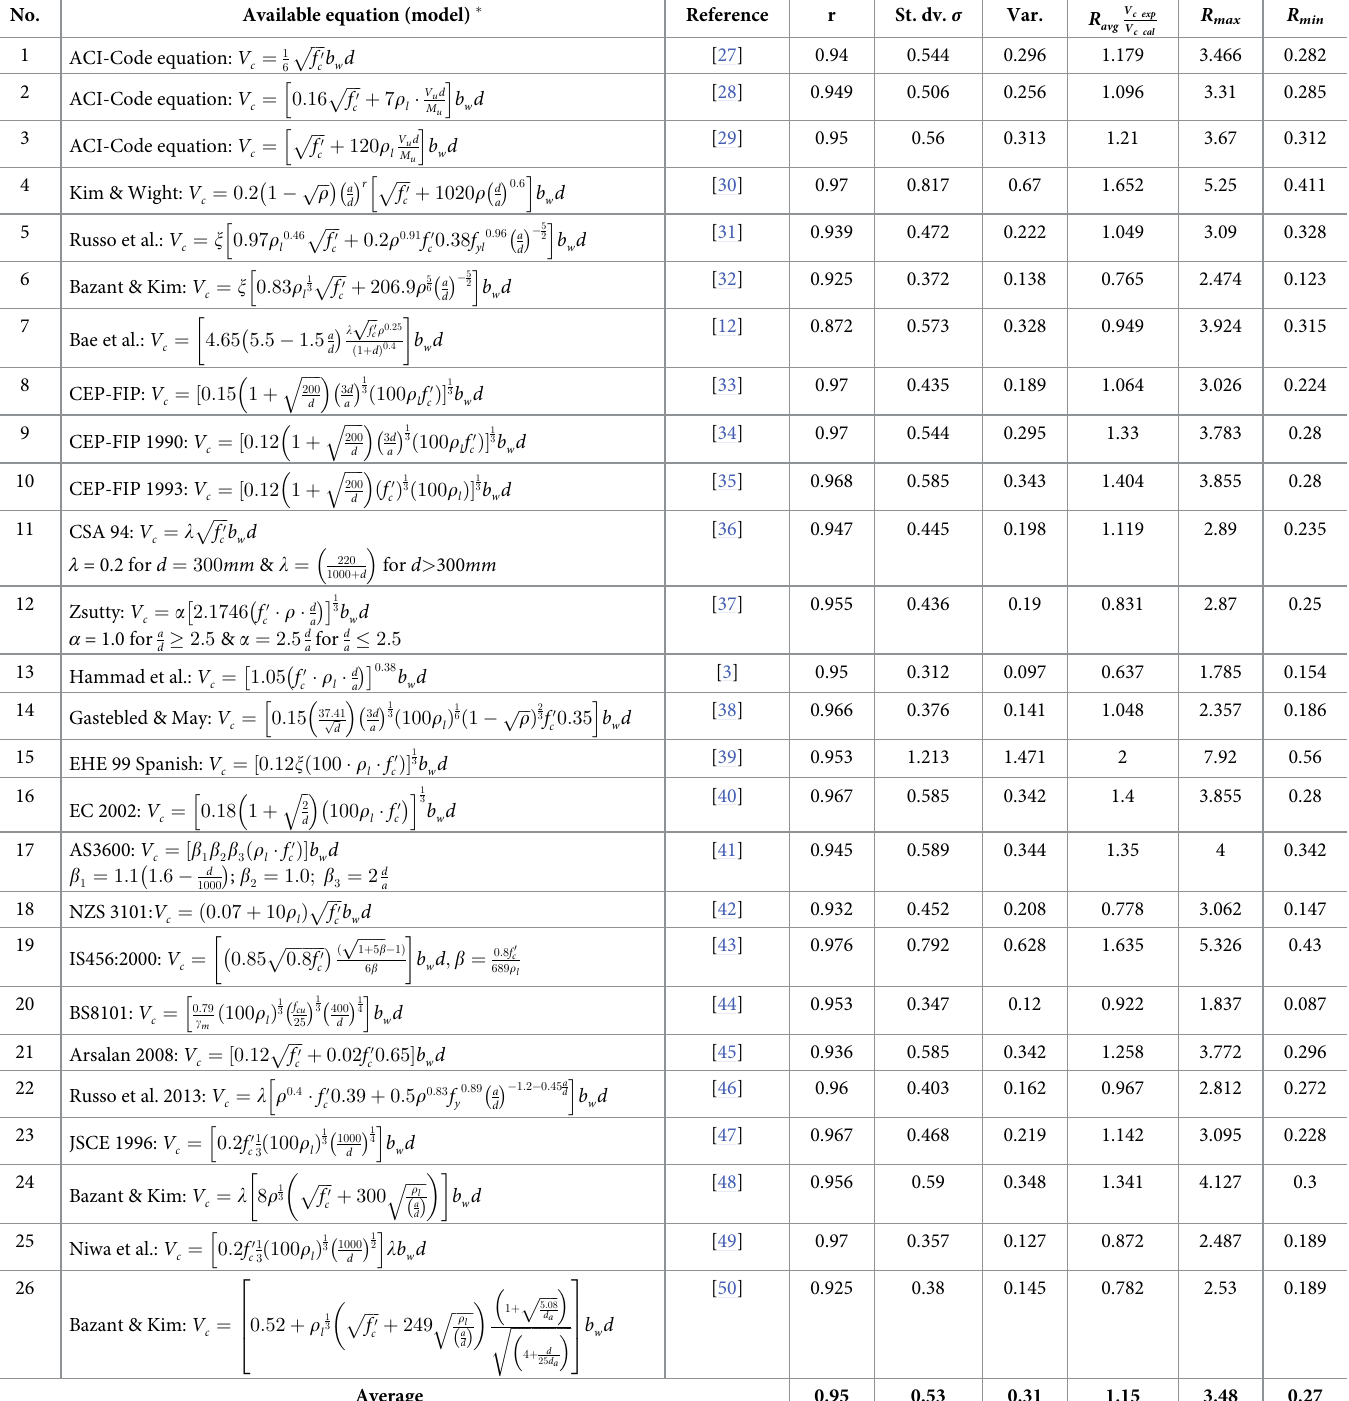
Table 4. The range of the experimental data and range of application of the mathematical proposed equations. No. Available equation (model) � Reference St. dv.